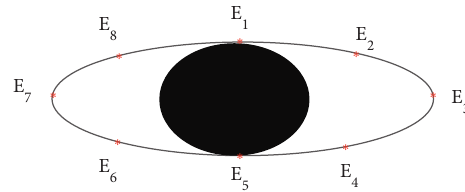
Figure 5: Schematic diagram of human eye